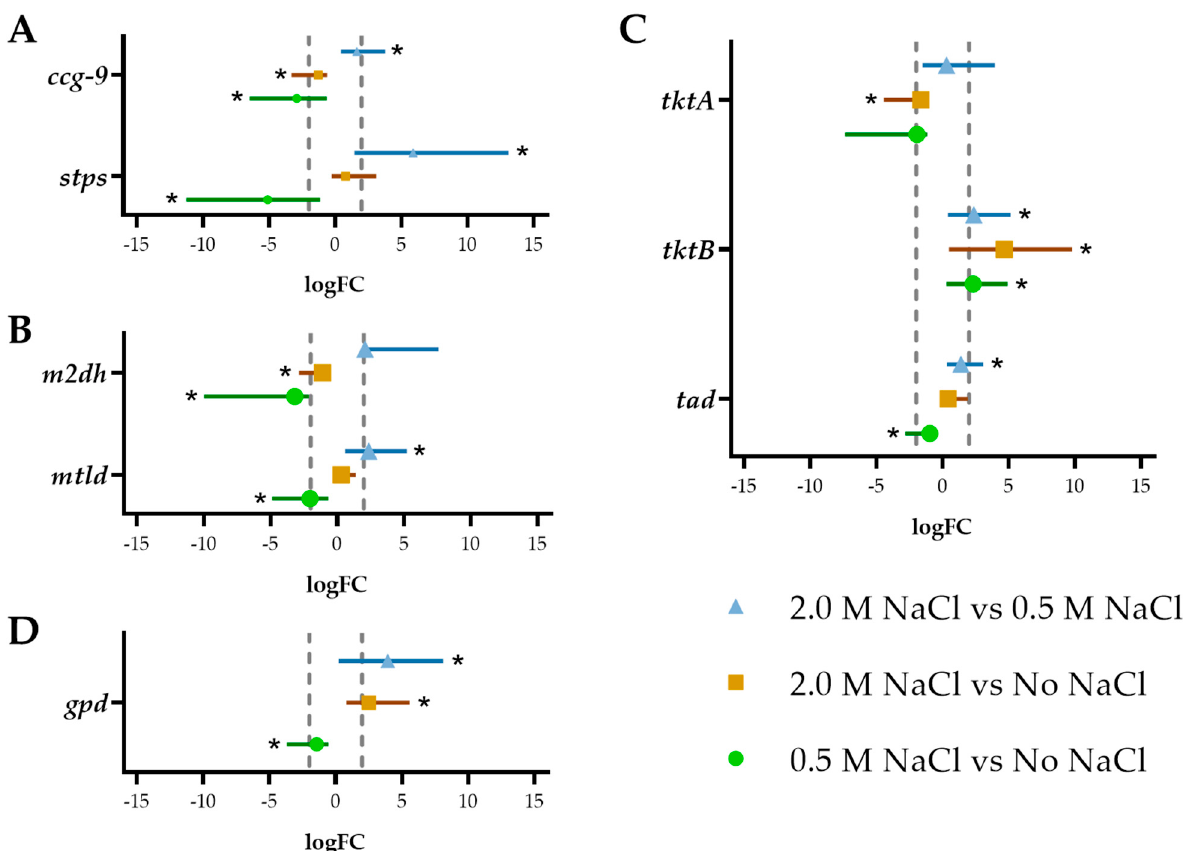
Figure 3. Expression analysis of transcripts related to osmolytes synthesis of A. sydowii in different salinities after 7 d of culture. The values correspond to the average and standard deviations of three biological replicates ( n = 3) and two technical qPCR replicates. Analyzed genes were grouped according to the pathway: ( A ) Trehalose synthesis, ( B ) Mannitol synthesis, ( C ) Pentose phosphate pathway (for arabitol and erythritol synthesis) and ( D ) Glycerol synthesis. Statistical significance (*) was assessed by a randomization test performed with the software Rest [46]. The dashed vertical lines correspond to a cutoff logFC = 2.